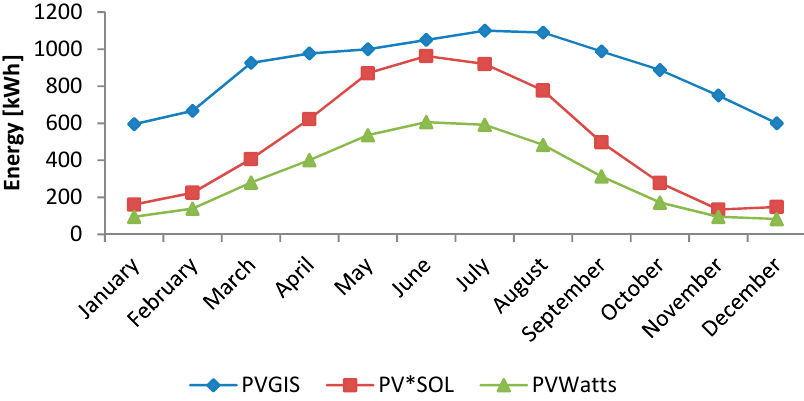
Figure 13. Monthly variation of energy generation for Girne.